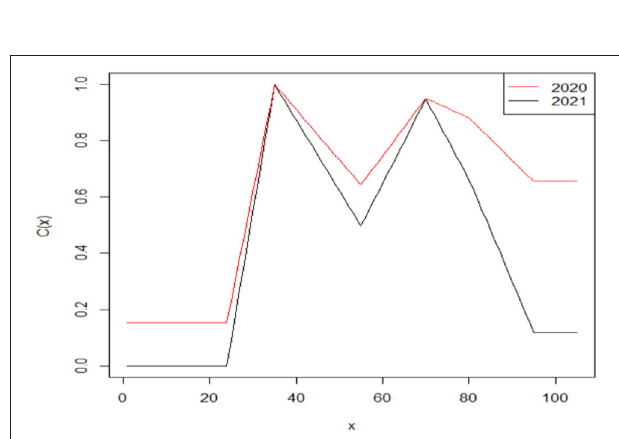
FIGURE 3 | Adverse mortality effect of COVID-19 on